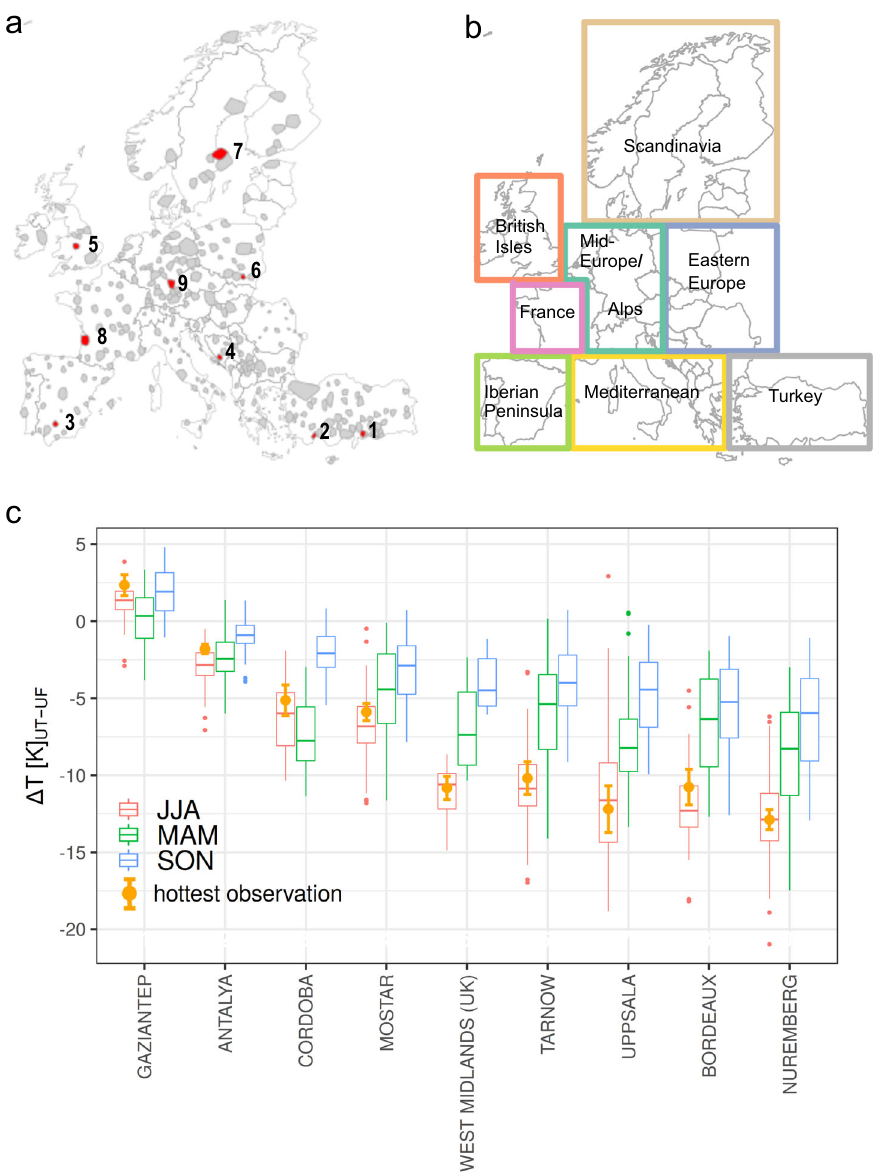
Fig. 2 Temperature differences between urban trees and continuous urban fabric for selected cities in Europe. a All cities together with their surroundings that were selected for analysis (grey) and cities for which results are shown in more detail (red). In each region, a representative city was selected (except for Turkey, where we show the results for two cities). b Geographic extent of the de fi ned European regions. c The LST differences between continuous urban fabric and areas covered 100% by urban trees (UT urban trees, UF continuous urban fabric). Boxplots of each city indicate the spread of temperature differences calculated for all summertime (JJA) observations (boxes show the fi rst and third quartile; whiskers show the largest/ smallest values, but do not extend beyond 1.5 times of the interquartile range; outliers are shown as separate points). The temperature difference observed when the background temperature was highest is shown as an orange dot together with error bars denoting standard